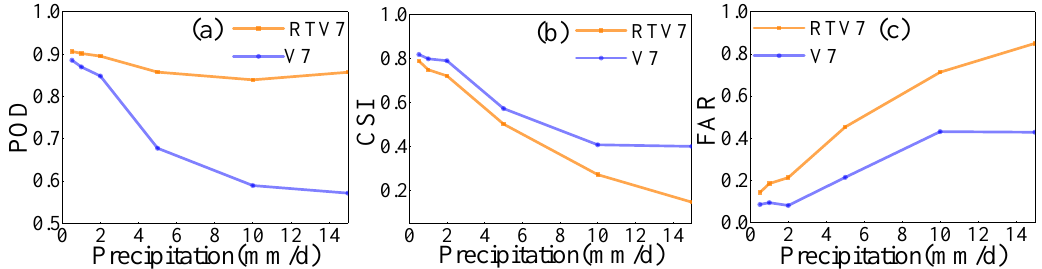
Figure 5. Statistical indices for different precipitation thresholds at the daily time scale: ( a ) probability of detection (POD); ( b ) critical success index (CSI); and ( c ) false alarm ratio (FAR).